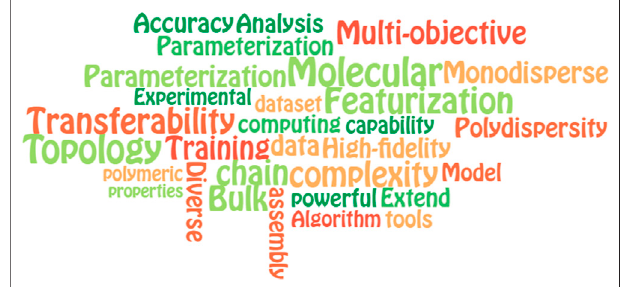
FIGURE 12 | Keywords of challenges and future directions in this fi